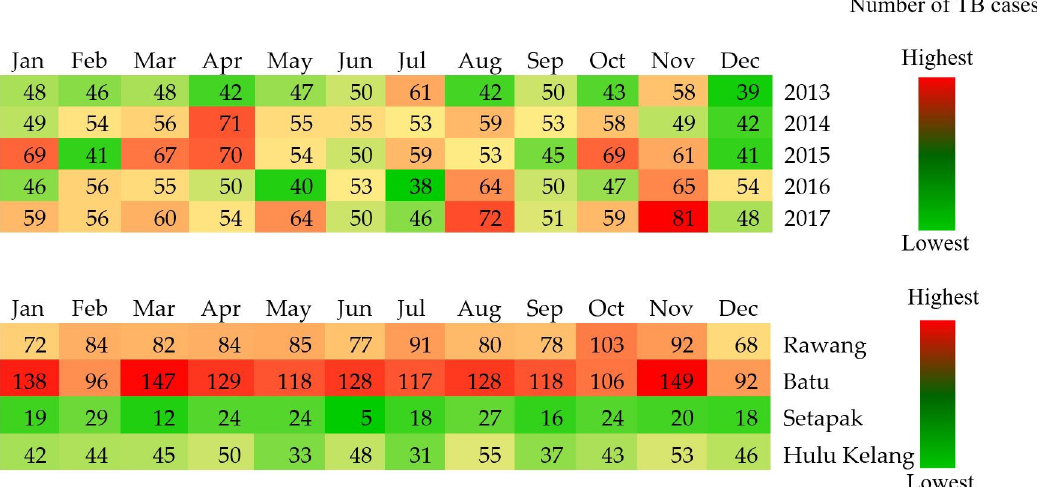
Fig 5. Heat map of TB cases by year and by mukim in Gombak, 2013 to 2017.